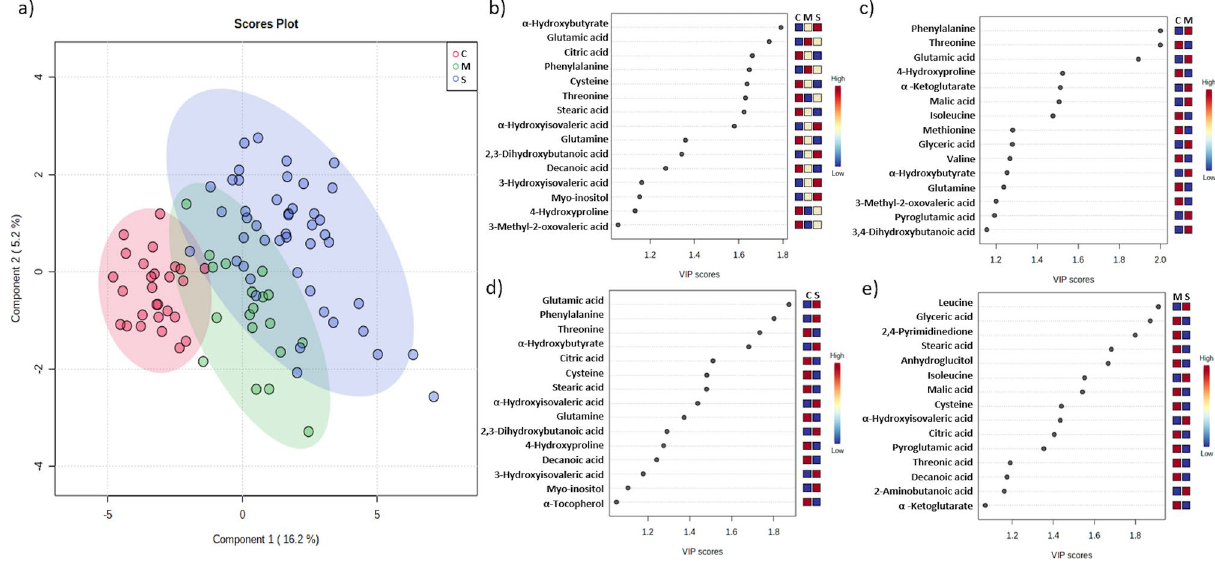
Figure 2. Partial least squares-discriminate analysis (PLS-DA) plot of differential metabolites from control and COVID-19 patients and their corresponding VIP values. ( a ) PLSDA score plots for control (H-red), mild (M-green) and severe (S-blue) patients .VIP schematic scores of PLS-DA analysis for CvsMvsS ( b ), CvsM ( c ), CvsS ( d ), and MvsS ( e ) groups.